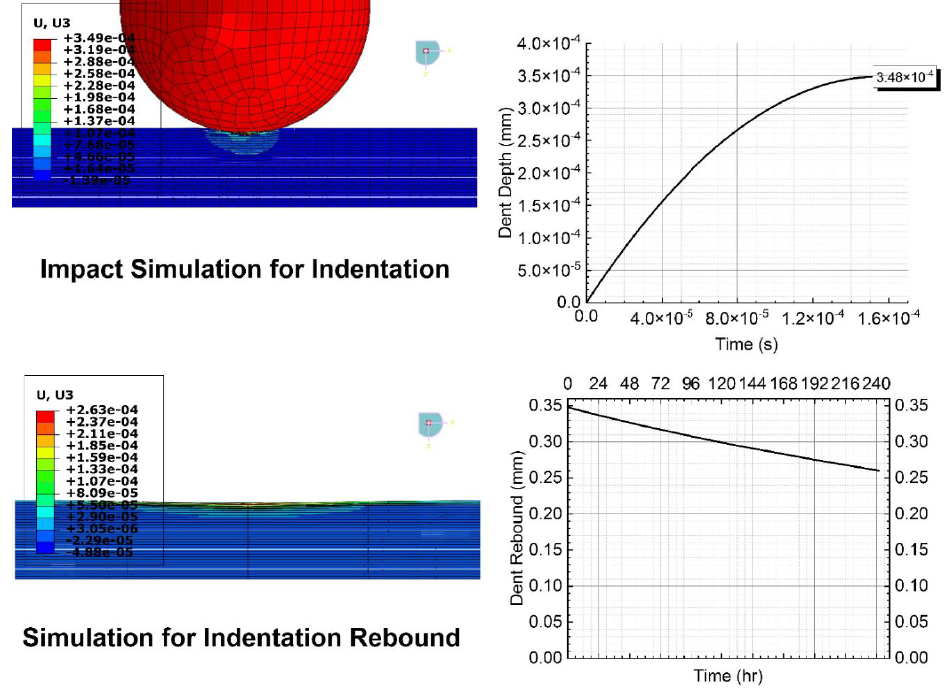
Figure 14. Case I: 50